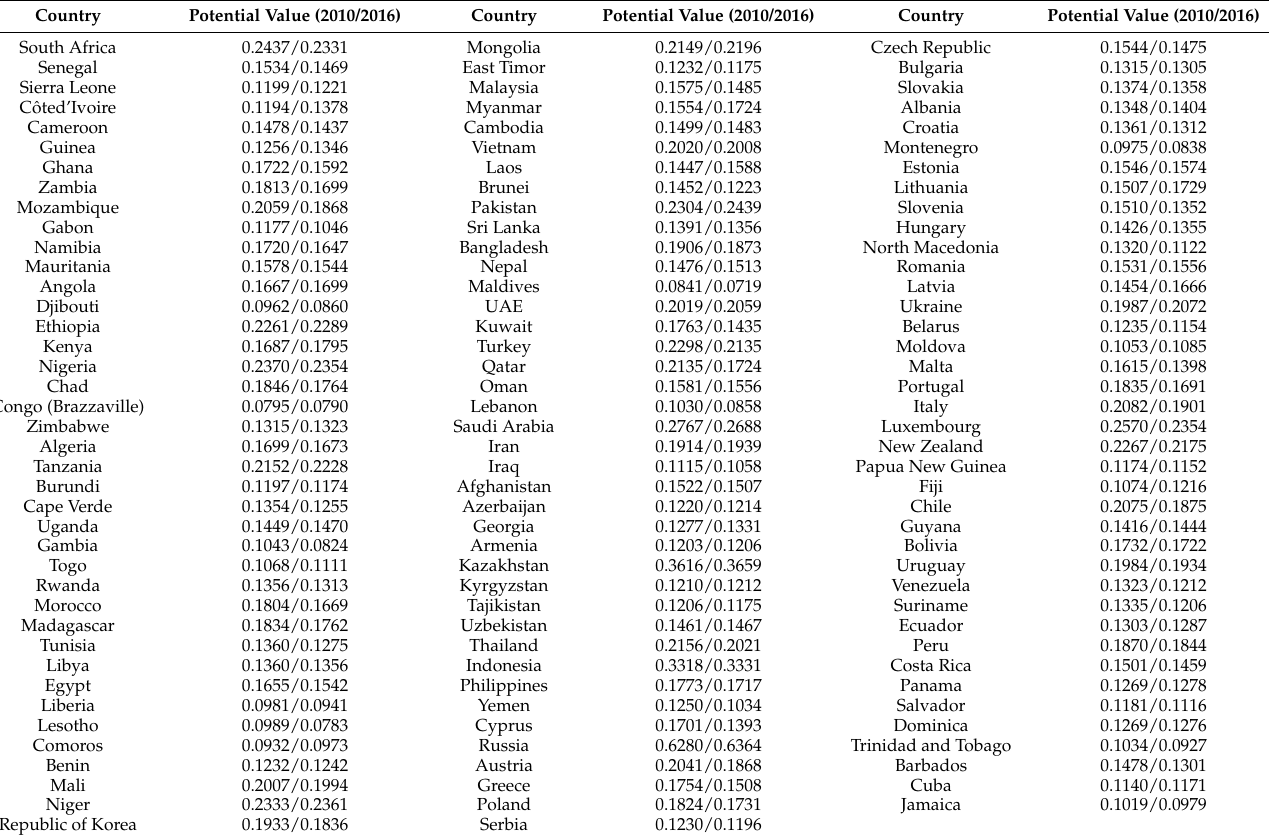
Table 5. The potential value of the arable land investment in countries along the “belt and road" initiative. Country Potential Value (2010/2016) Country South